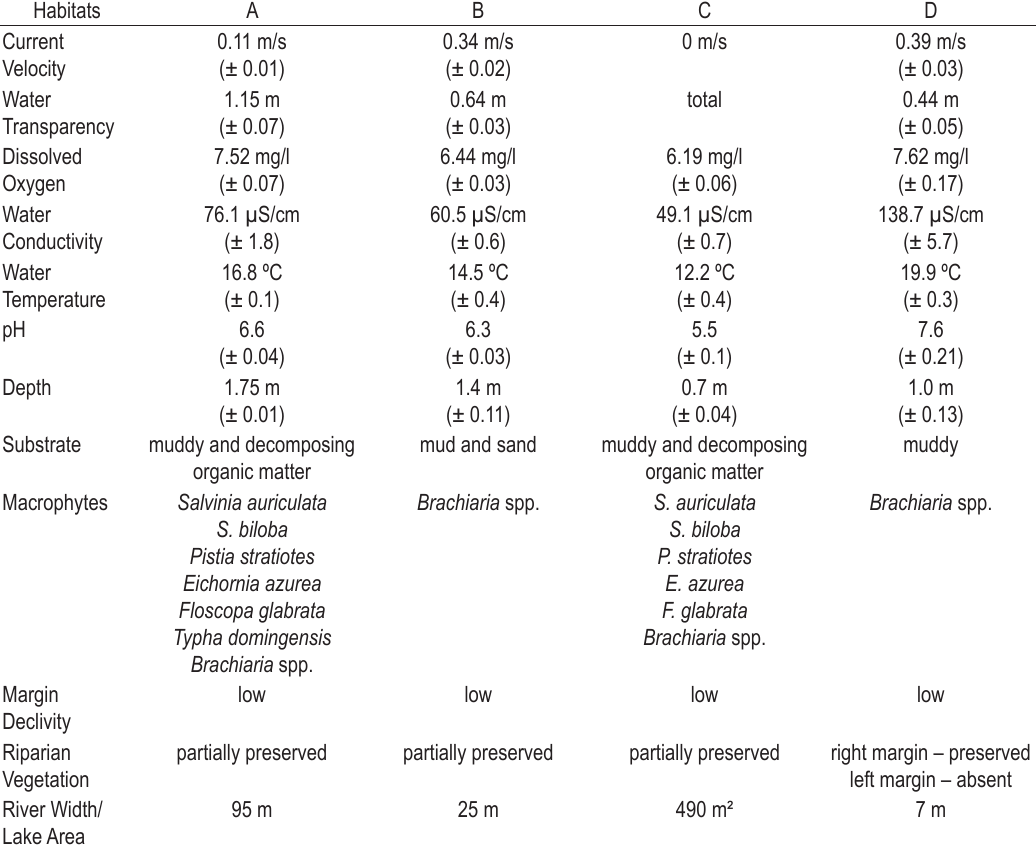
Table 1. Characteristics of the four studied habitats in the Jacaré-Guaçu River Basin: a) reservoir of Gavião Peixoto Dam; b) Jacaré-Guaçu River; c) floodplain lake; d) Chibarro River. The mean data (± standard error) were calculated from pooling the two studied periods (22-25/June/2008 and